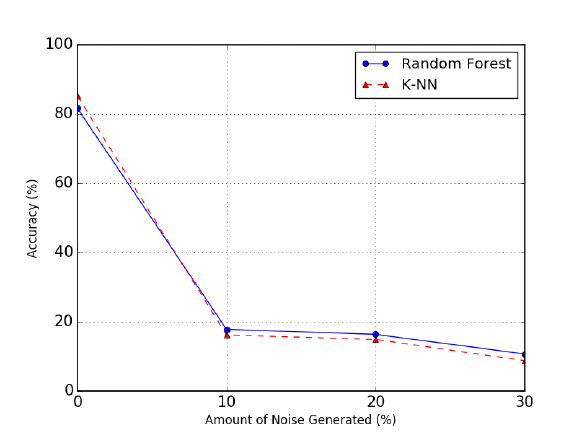
Figure 10. The accuracy of the website fingerprinting attack for real-world experiments with varying amounts of noise generated. Classifier used was Random